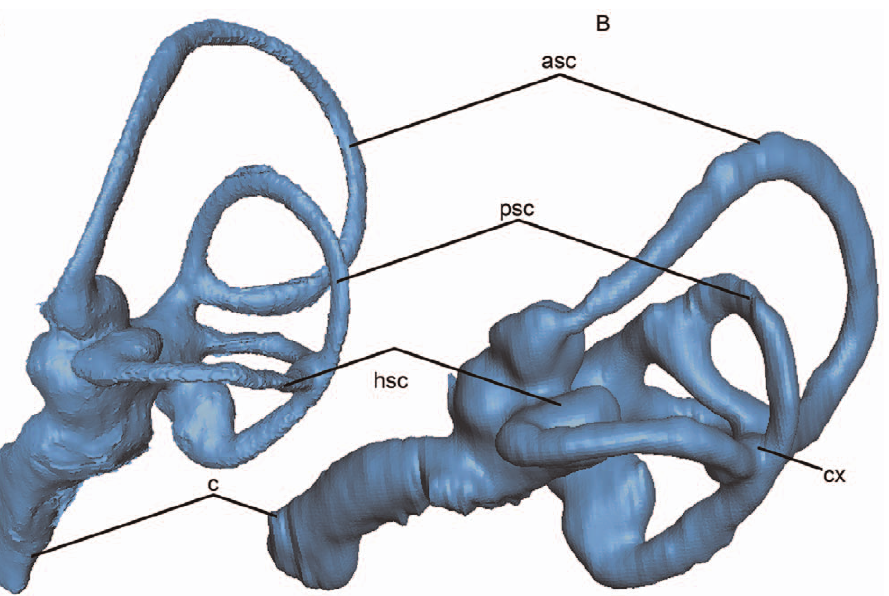
Figure 15. Left endosseous labyrinths of the aquatic, flightless Great Auk Pinguinusimpennis (A) and the terrestrial foraging, volant Killdeer Charadriusvociferus (B) in lateral view (not to scale for comparison). Note the differences in the orientation of the labyrinths (based on horizontal semicircular canal), compression of the semicircular canals (i.e., elliptical versus rounded shape), overall thickness of canals, curvature of the cochlear duct, shape of the distal end of the cochlear duct, and participation of the anterior semicircular canal in the common